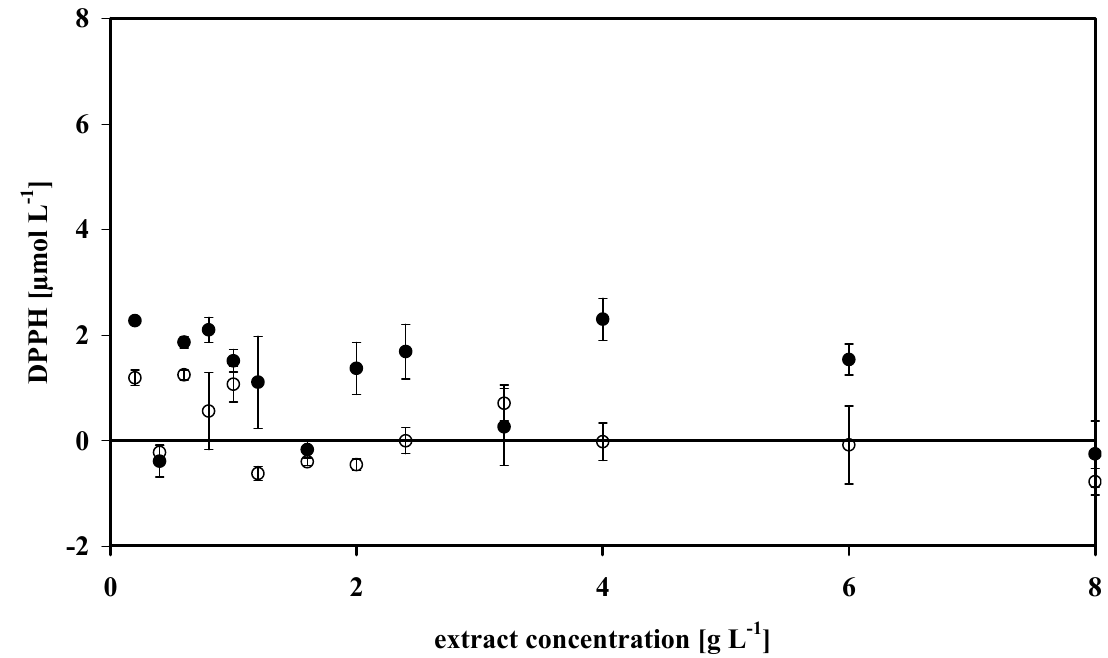
Figure 3. Absorbance decrease of the DPPH radical measured at 550 nm after adding α -tocopherol for Synechocystis sp. PCC6803. The reference cuvette is filled with the same extract concentration as in the measuring cuvette. Open circles represent the data obtained from low DPPH concentration (38 µmol L -1 ). Closed circles represent the data obtained from high DPPH concentration (76 µmol L -1